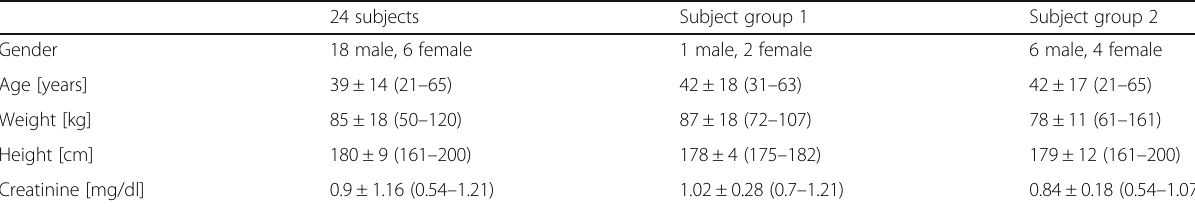
Table 1 Subject demographics: basic subject data presented as mean value ± standard deviation, range from minimum to maximum value in